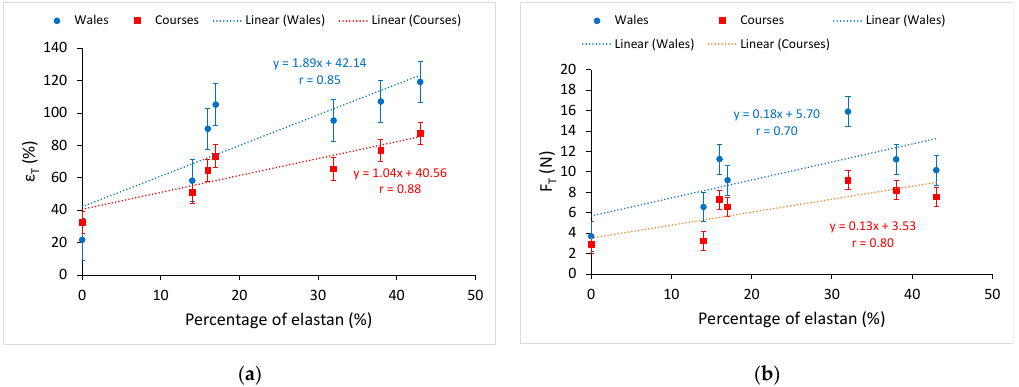
Figure 7. Elastic limit values depending on the percentage of elastane: ( a ) elongation ε T at point T; ( b ) tensile force F T at point T.